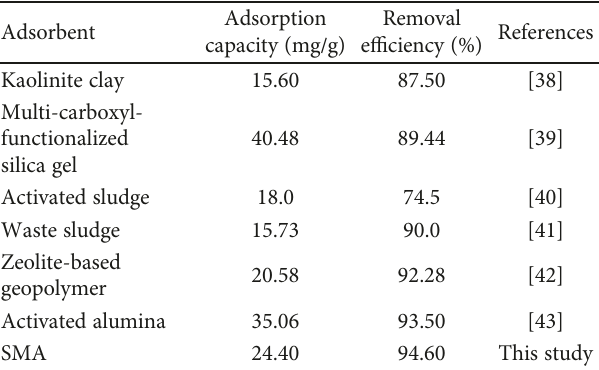
Figure 14: The FTIR spectra in the wavenumber range of 400 – 4000 cm − 1 for SDS-modi fi ed γ -Al Table 2: Adsorption capacity and removal e ffi ciency of Cd 2+ using surfactant-modi fi ed alumina (SMA) and other